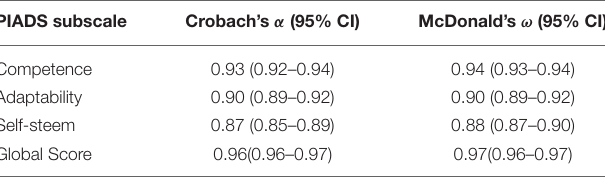
TABLE 4 | Ordinal Cronbach’s alpha and McDonald’s omega (with bootstrap confidence intervals) scores in each subscale of the Spanish (Spain) Psychosocial Impact of Assistive Device